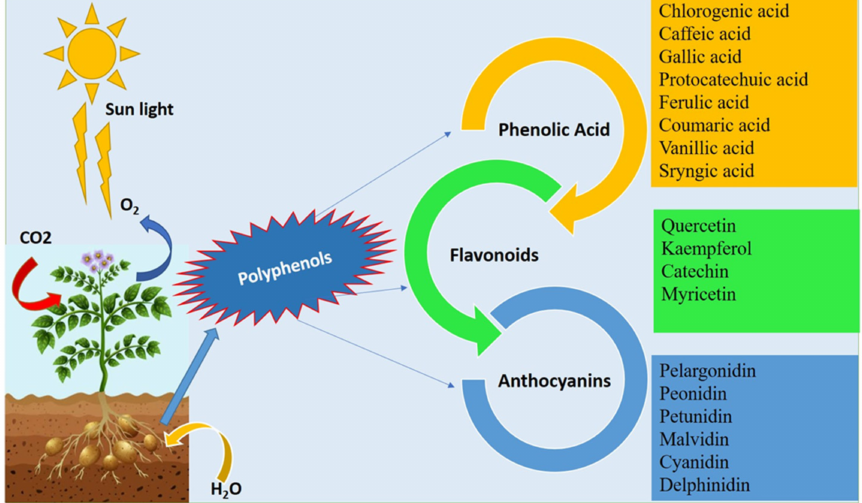
Figure 1. Various polyphenolic compounds present in potato